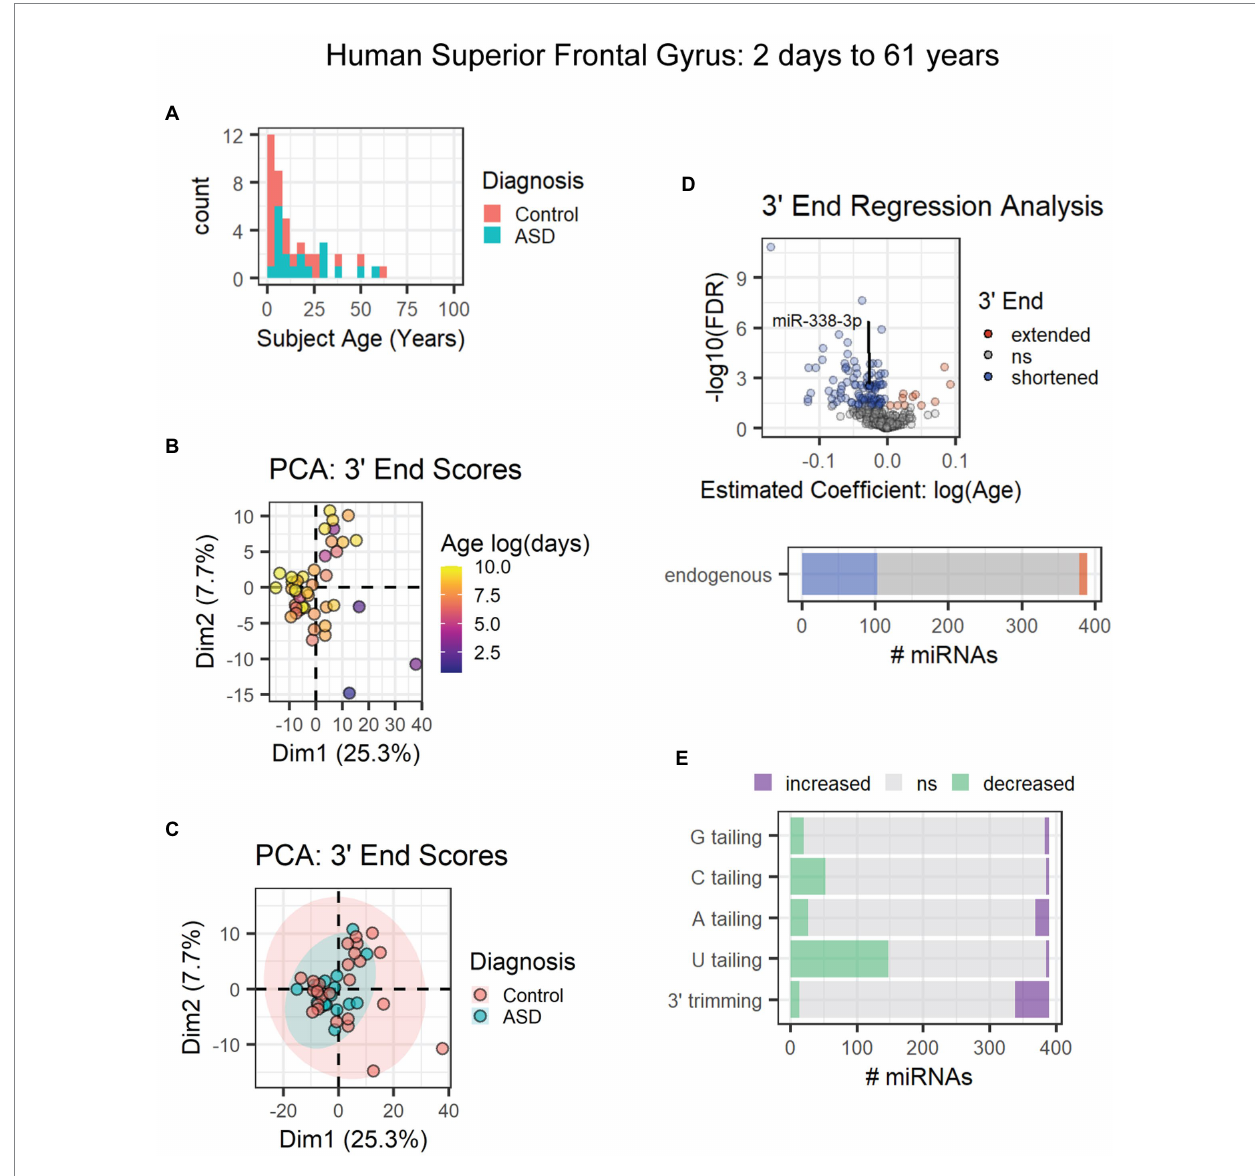
FIGURE 7 Age-associated 3 ′ shortening of miRNAs occurs in human superior frontal gyrus between 2 days and 61 years of age. (A) Age distribution and diagnosis information for human subjects used for analyses in (B–E) . After outlier removal, 44 subjects were included. (B) PCA suggests a weak relationship between subject age and 3 ′ end scores. Sample SRR1510086 was removed as an outlier based on PCA results (not shown). (C) PCA suggests no relationship between subject diagnosis and 3 ′ end scores in the first two dimensions. (D) 3 ′ ERA for human cortex. Ages were log transformed prior to analysis. 103 of 389 miRNAs underwent 3 ′ shortening with age. (E) 3 ′ ERA by modification type revealed that 3 ′ shortening was primarily due to increased 3 ′ trimming and decreased U tailing with